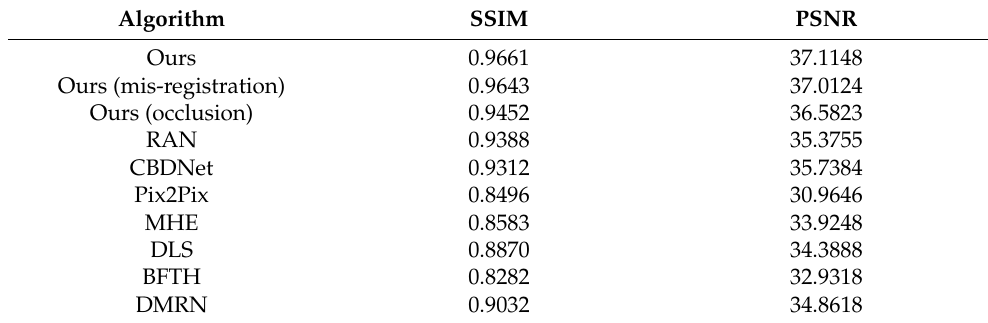
Table 2. SSIM and PSNR of each